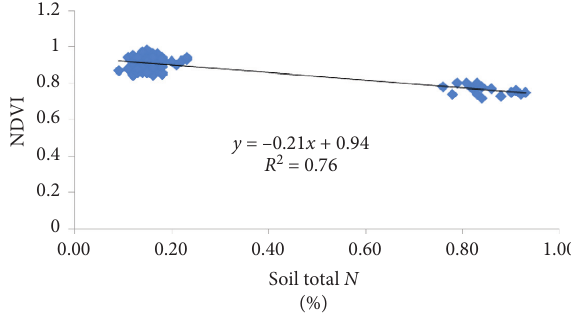
Figure 3: Relationship between pepper Normalized Difference Vegetation Index (NDVI) and soil total N in a pepper farm grown with mature